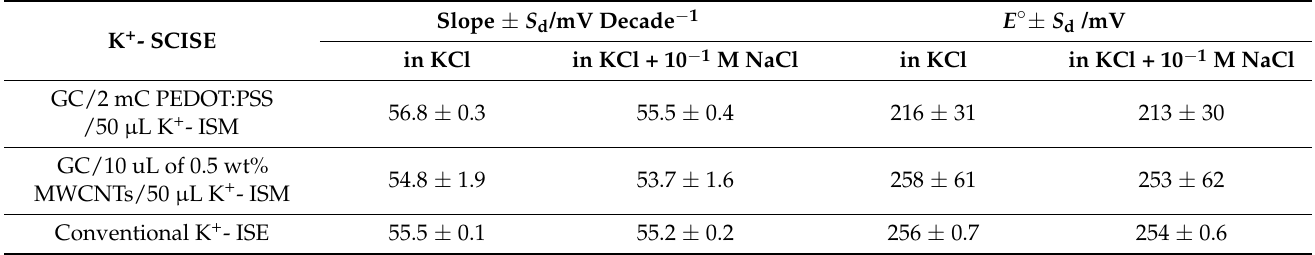
Table 3. Results from the potentiometric measurements of K + - SCISEs. S d = standard deviation (n =